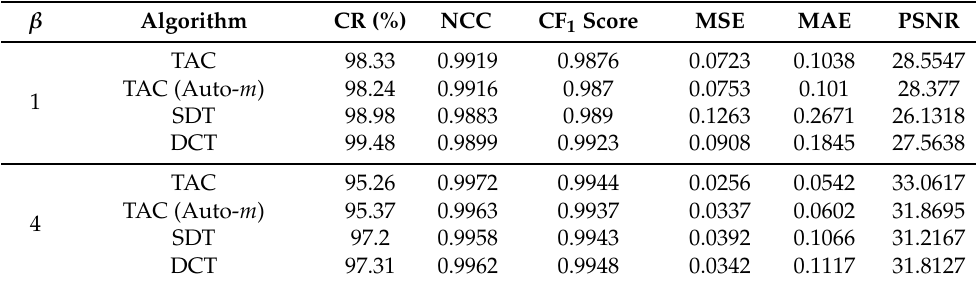
Table 6. Compression result: Dataset 2.